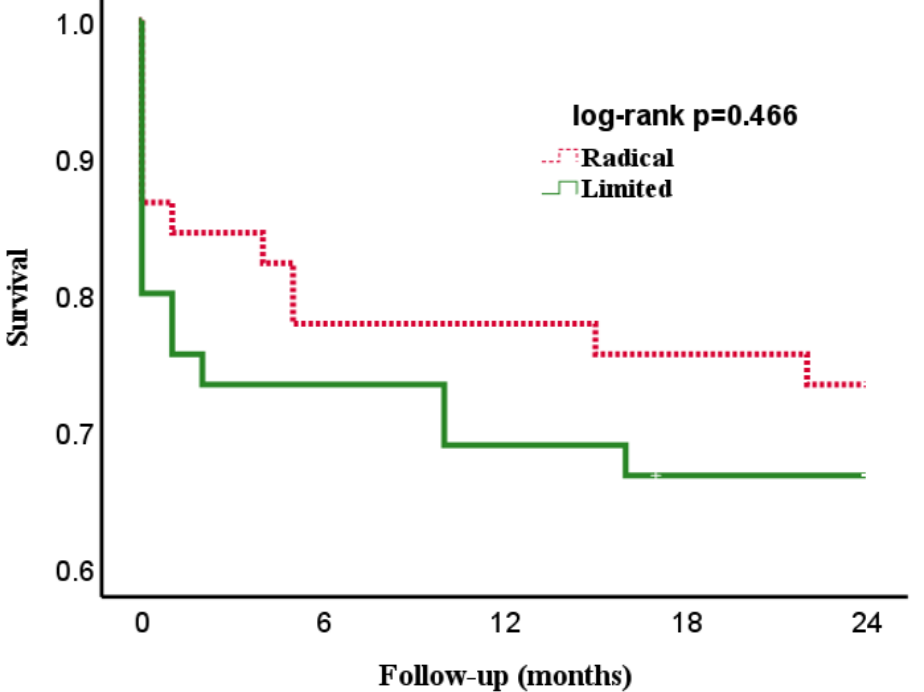
Figure 1. Kaplan–Meier curve showing the overall-survival of patients with infective endocarditis of the native mitral valve undergoing surgical therapy by limited-resection (limited) and radical- resection (radical) strategy.